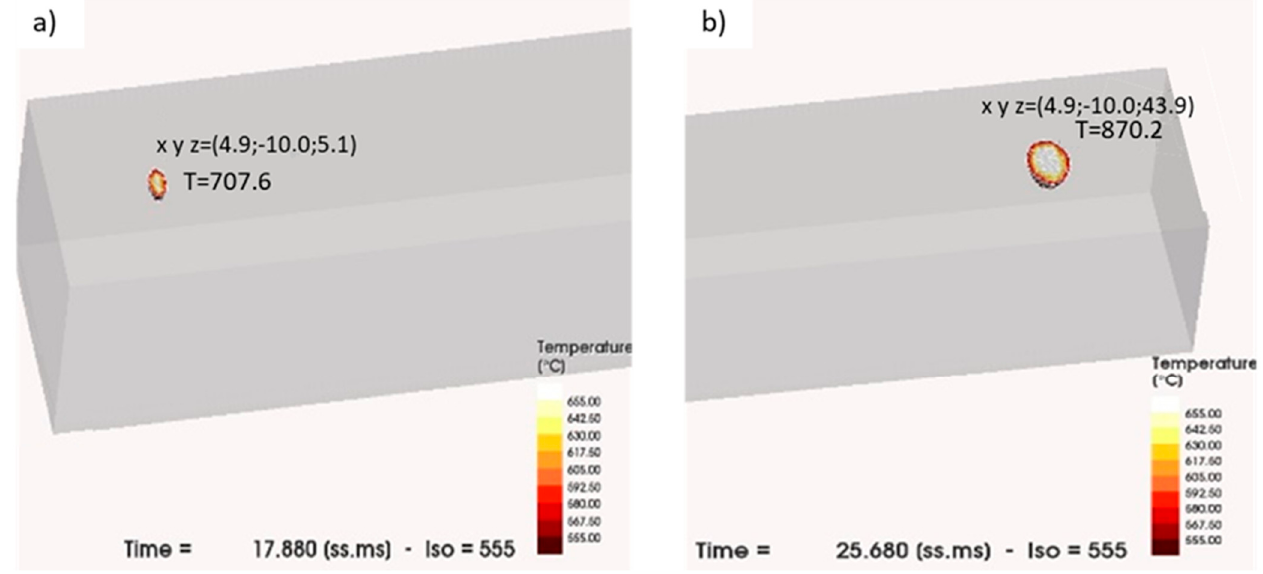
Figure 3. Representation of the simulation at ( a ) the beginning and ( b ) the end of the melting step.